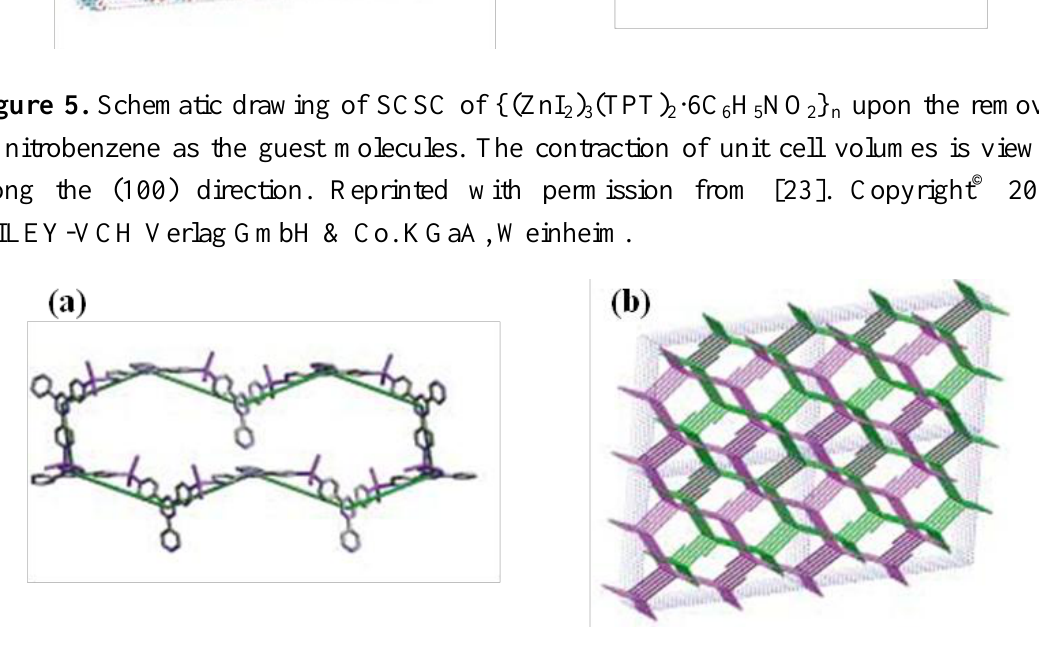
) (TPT) ·6C H NO } upon the removal 2 3 2 6 5 2 n